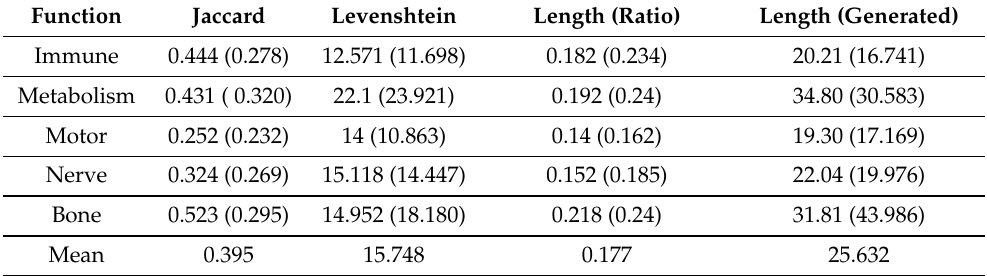
Table 5. The Jaccard measure, the Levenshtein distance, and the length (ratio) µ ( σ ) of the function of organ sequences.